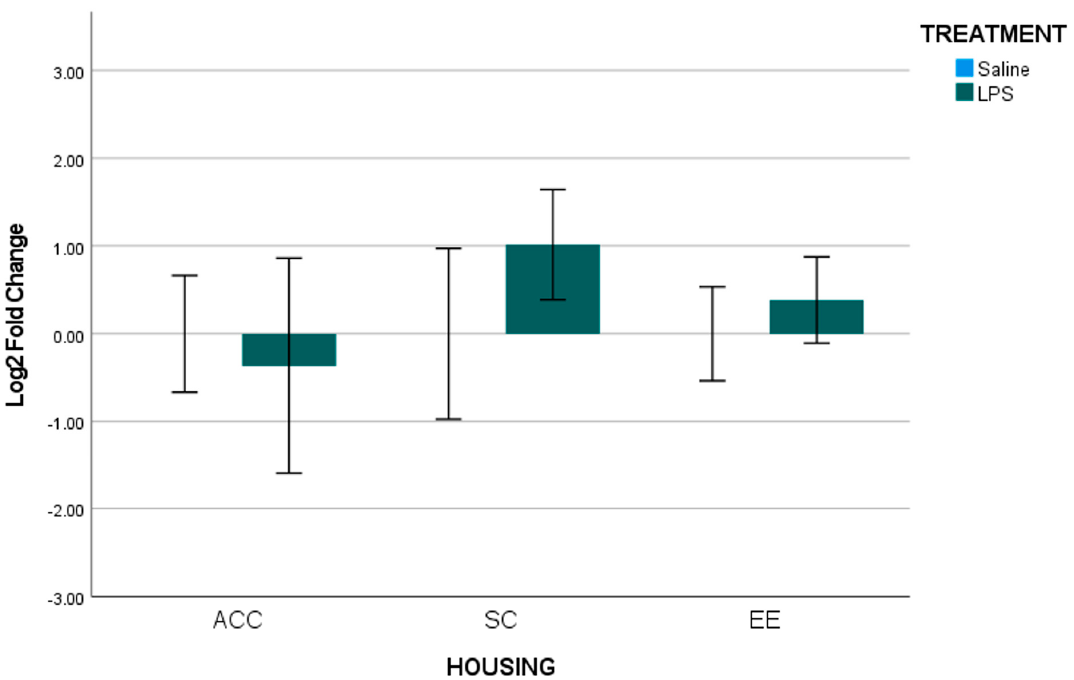
Figure 4. B2 SINE expression for Standard vs. Enriched and Standard vs. Social Control Housing in the MPOA. Standard (Saline: n = 12, LPS: n = 10), Enriched (Saline: n = 12, LPS: n = 14), Social Control (Saline: n = 13, LPS: n = 15). A two-way ANOVA revealed there were no simple main effects from housing or treatment. There were no statistically signi fi cant interactions. (* p ≤ 0.05, a p < 0.05, main e ff ect of treatment, b p < 0.05, main e ff ect of housing; mean ± SEM). Finally, the hippocampus was selected for analysis for its broad reaching impacts on behavior, memory, and anxious responses [82–89]. In dorsal hippocampus, there is no in- teraction e ff ect (F (2,74) = 0.026, p = 0.974), no e ff ect of housing (F (2,74) = 0.026, p = 0.974), and no e ff ect of treatment (F (1, 74) = 2.379, p = 0.128). In the ventral hippocampus, there was no interaction e ff ect (F (2,75) = 1.843, p = 0.166), no e ff ect of treatment (F (1,75) = 0.001, p = 0.982), and no e ff ect of housing (F (2,75) = 0.894, p = 0.414) (Figures 5 and 6).